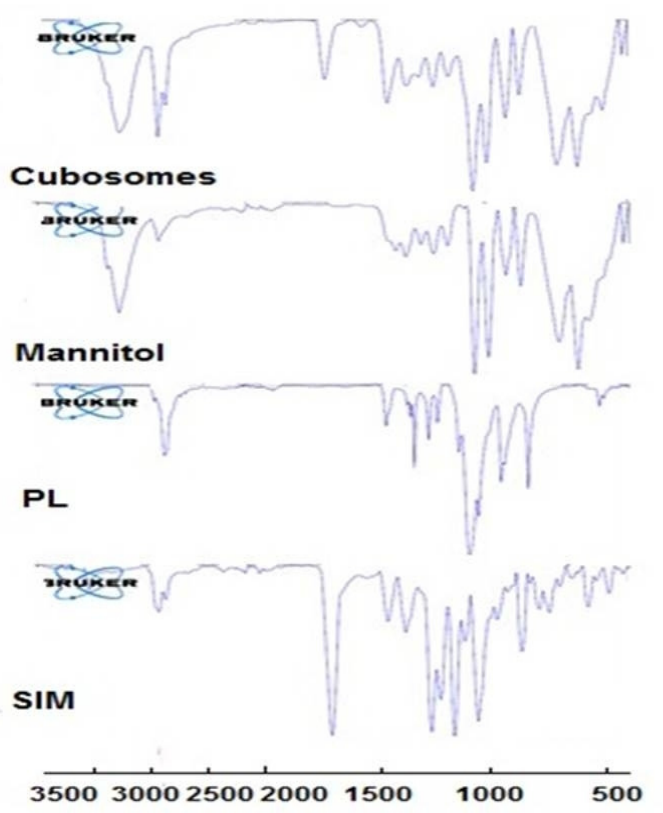
Figure 3. FTIR spectra of SIM, PF-127, mannitol and SIM-loaded cubosome.